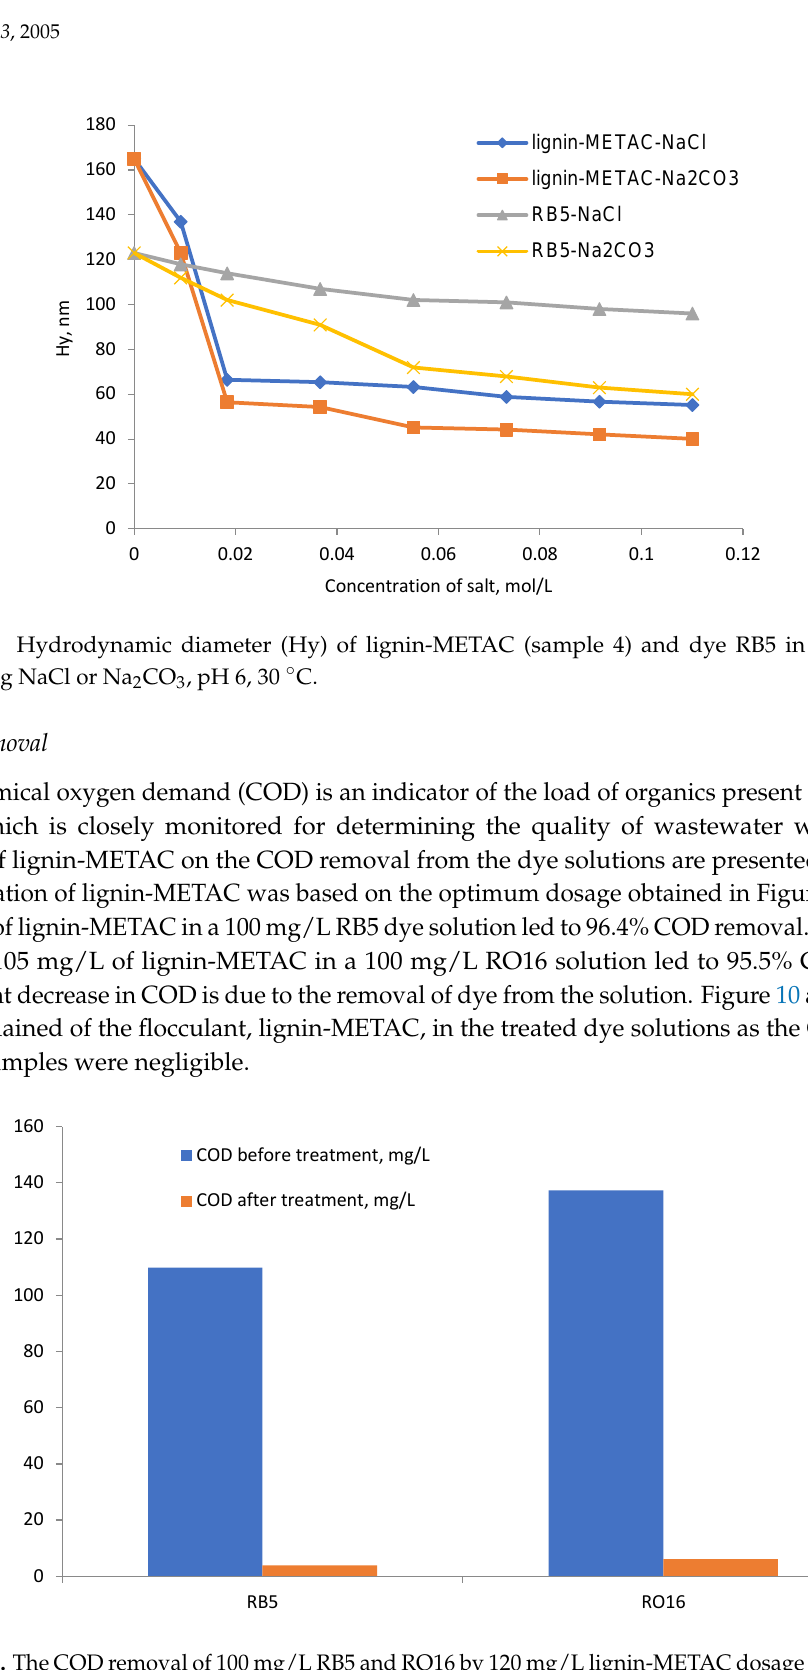
Figure 10. The COD removal of 100 mg/L RB5 and RO16 by 120 mg/L lignin-METAC dosage (sample 4) for RB5 and 105 mg/L lignin-METAC (sample 4) dosages for RO16 pH 6, 30 °C.